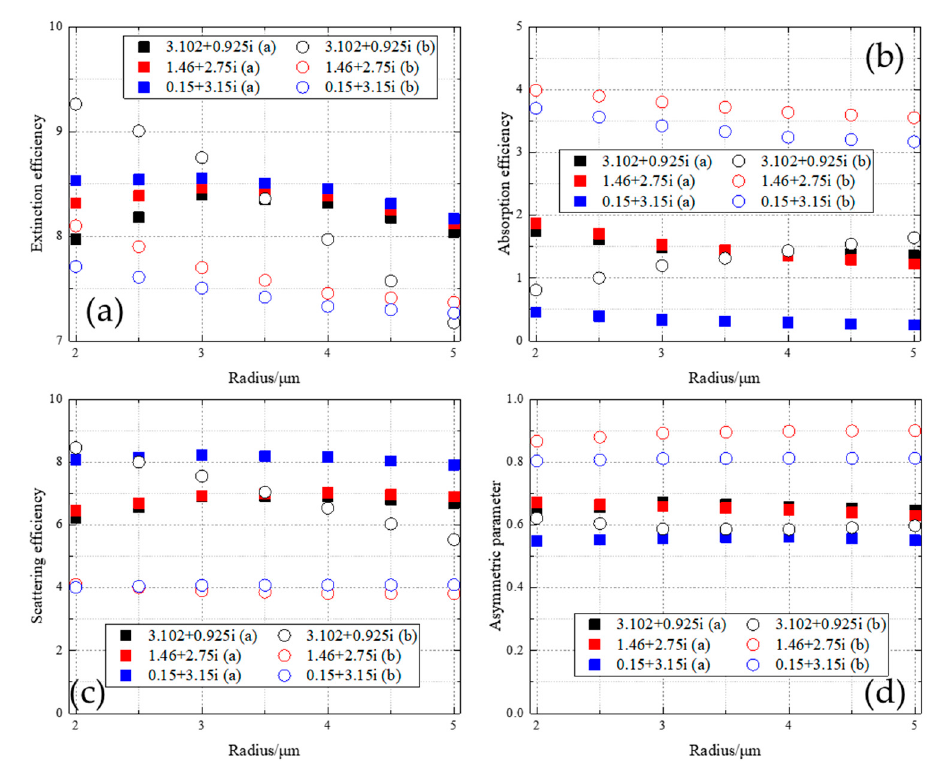
Figure 4. Radiometric properties at various particle radii for particle aggregates of different minor components at f = 25% (square symbol: Mode A, with the minor component particles randomly positioned; circle symbol: Mode B; black symbol: minor component m 2 = 3.102 + 0.0925i; red symbol: minor component m 2 = 1.46 + 2.75i; blue symbol: minor component m 2 = 0.15 + 3.15i). ( a ) Extinction efficiency; ( b ) absorption efficiency; ( c ) scattering efficiency; ( d ) asymmetric parameter.